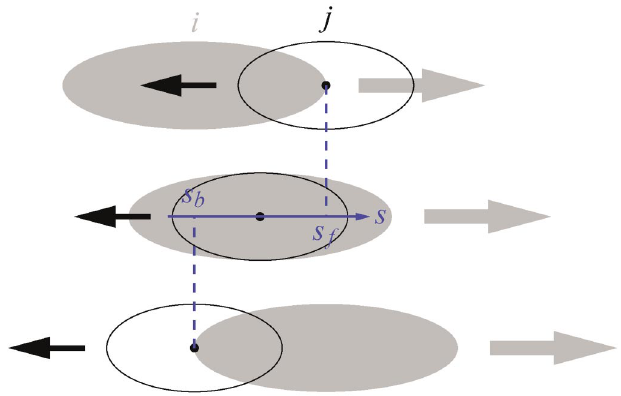
FIG. 2. (Color) Interpolation scheme of field. The beam-beam force experienced by slice i and generated by slice j is consid- and s . The point ered. The potential by j is computed twice at s f b s is the position where the front end of i meets the center of j , f and s the position where the back end meets the center. The b (cid:14) s (cid:14) s (cid:3) can be calculated by linear potential by j at s (cid:1) s b f